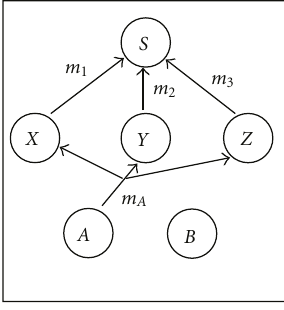
Figure 2: Example of forwarding after